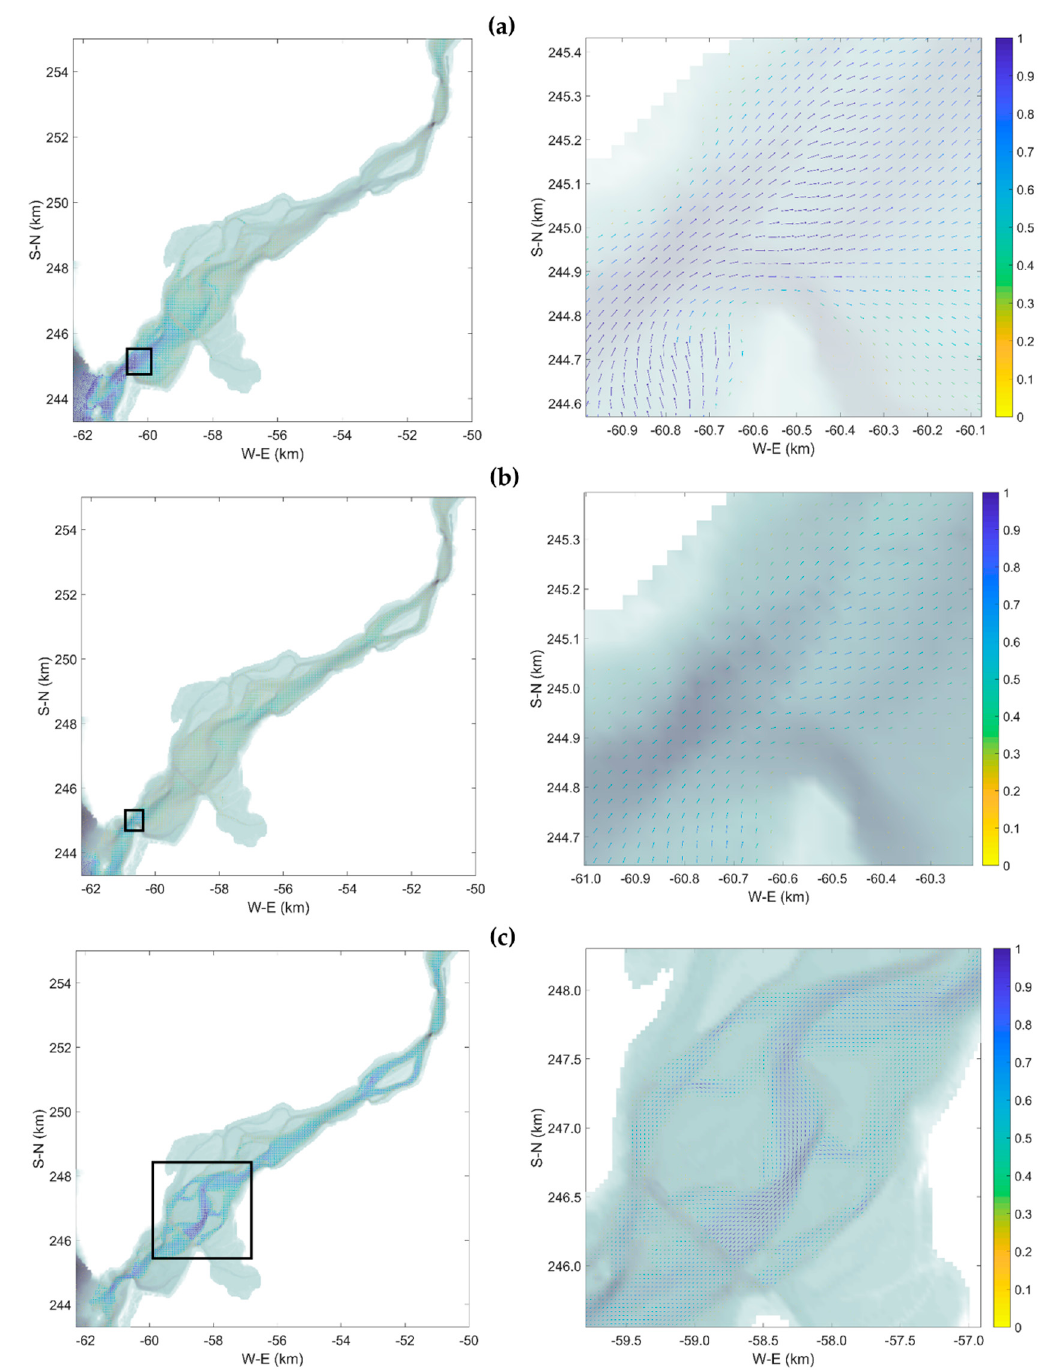
Figure 10. Scenario S2: velocity patterns and magnitude (in m ∙ s − 1 ). ( a ) Flow rate ~450 m 3 ∙ s − 1 and tidal level +1.60 m; ( b ) flow rate ~110 m 3 ∙ s − 1 and tidal level +0.80 m; and ( c ) flow rate ~110 m 3 ∙ s − 1 and tidal level − 0.80 m.